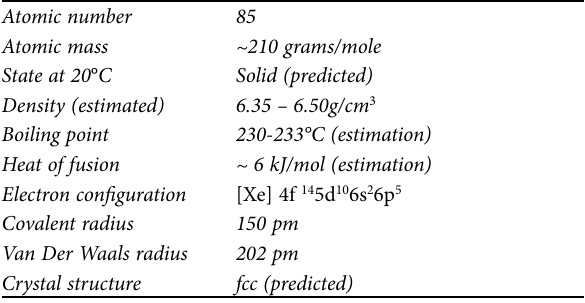
Table 1. Selected Physical Properties of